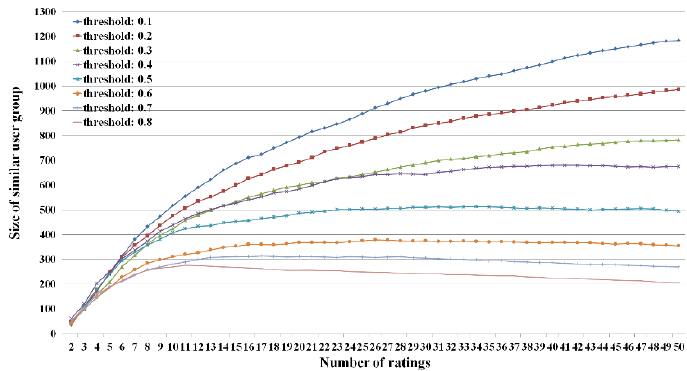
Figure 11. Size of similar user group according to the different numbers of ratings based on the Pearson correlation coefficient.